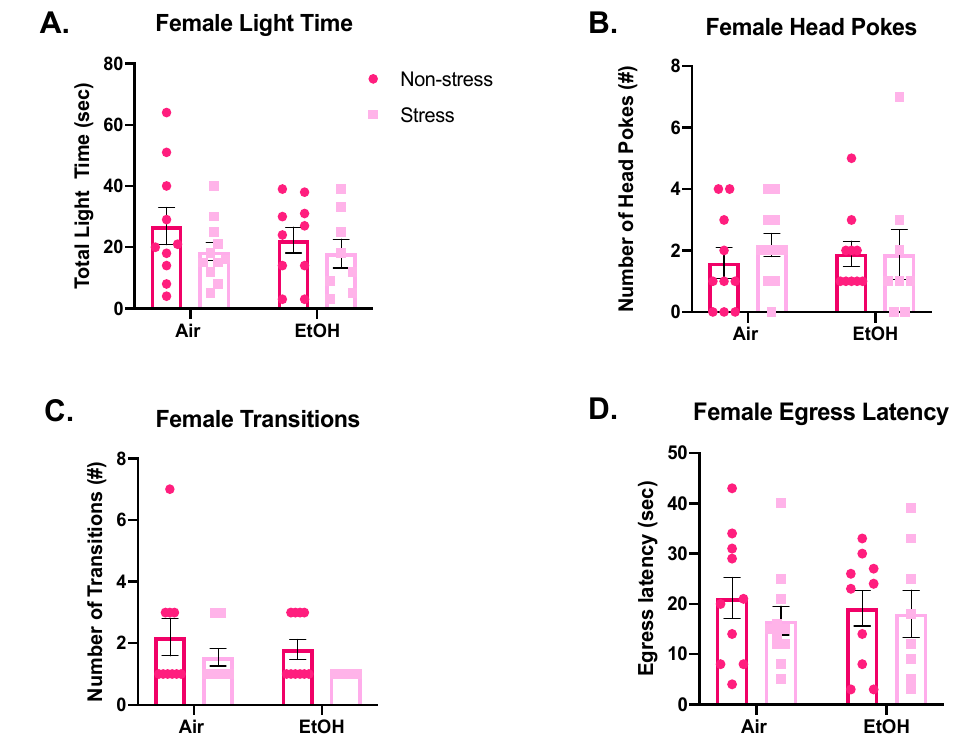
Figure 7. Comparison of female anxiety-like behaviors measured in the light–dark box by adolescent air or ethanol (EtOH) exposure in the non-stress group or following two days of forced swim stress, namely time spent in the light side ( A ), frequency of head pokes into the light side ( B ), number of transitions between the light and dark side ( C ), and latency to first cross into the dark side ( D ). There were no significant effects of ethanol or stress on any measure in females.